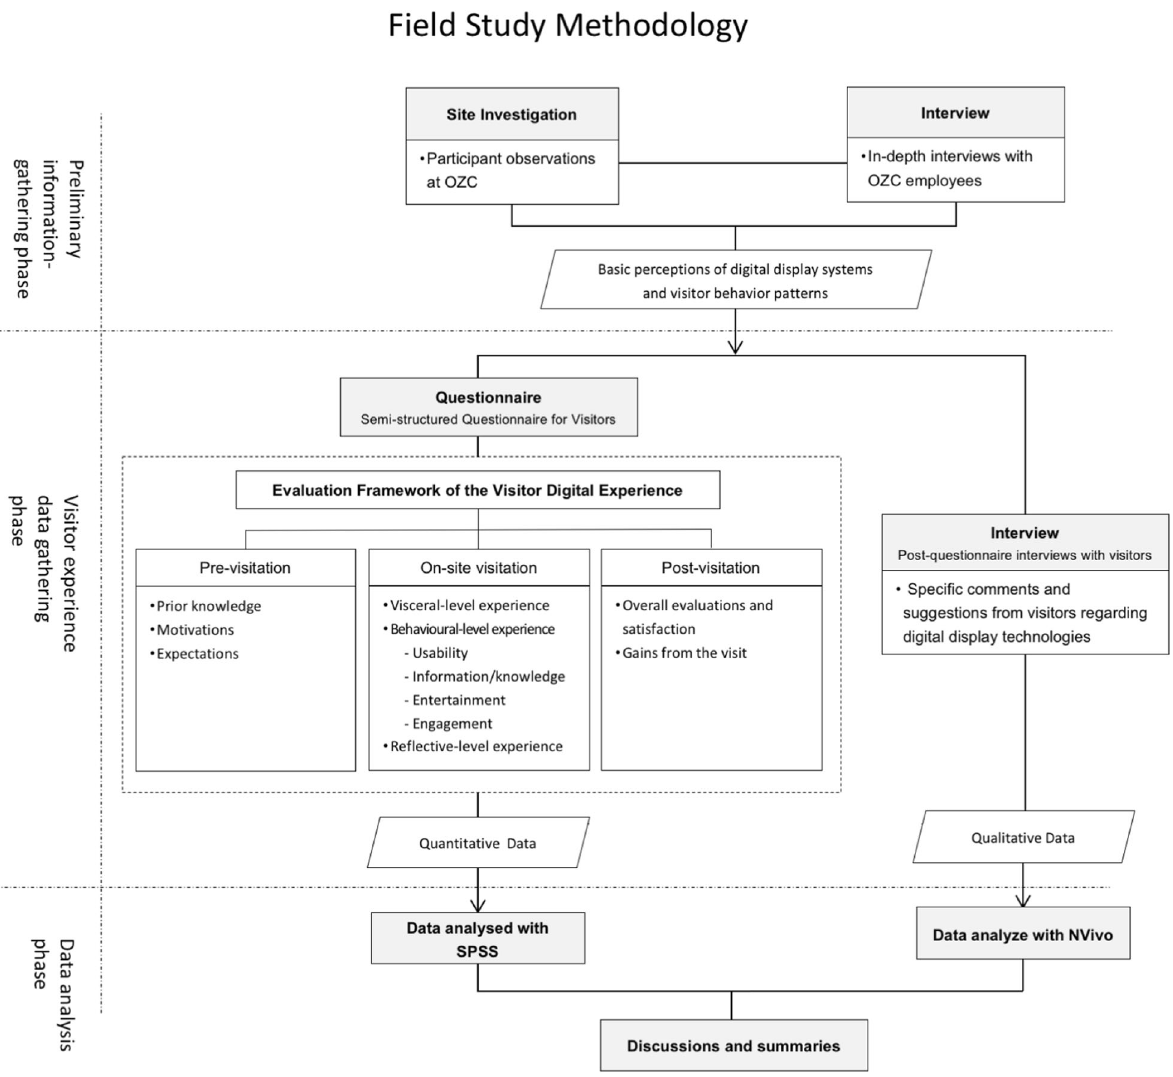
Fig. 2 Research framework (Source: the